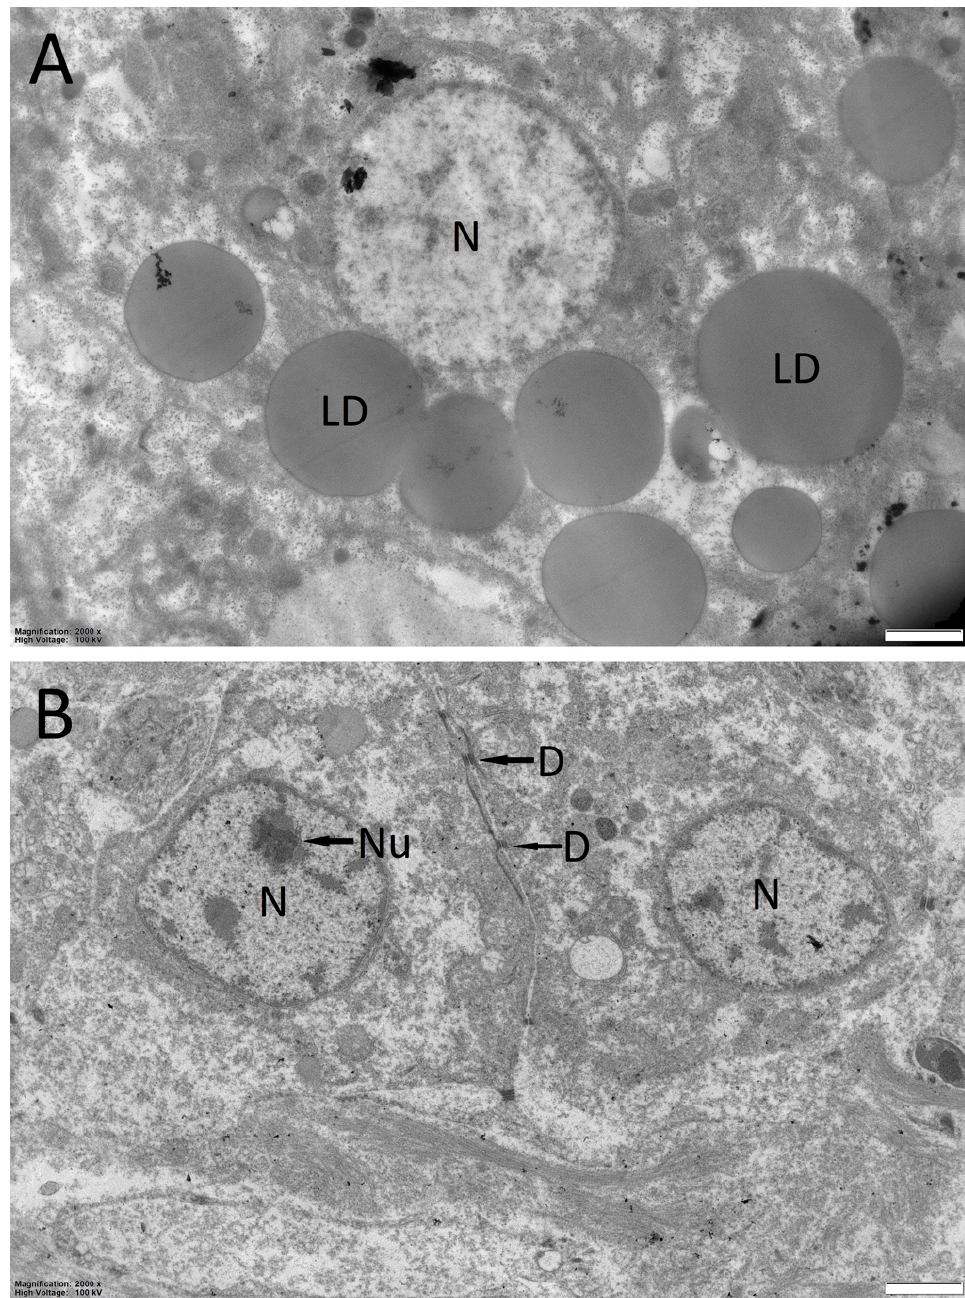
Figure 5. Hepatocyte ultrastructure in C. gobio ; ( A ) cytoplasm filled with large lipid droplets in a steatotic liver (male, June, But Stream). ( B ) hepatocytes without lipid droplets (male, June, Dimon Lake). D: desmosomes; N: nucleus; Nu: nucleolus; LD: lipid droplets. Calibration bars = 2 µm.